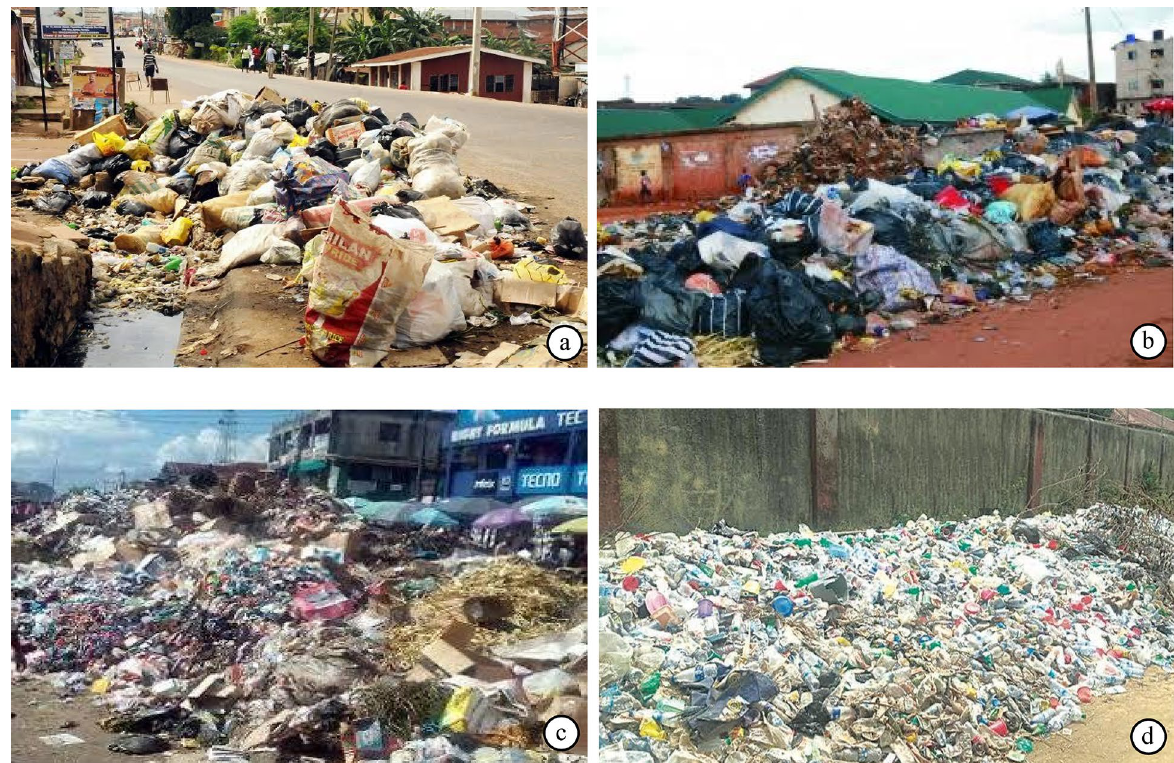
Figure 7. Benin City MSW street-side dumping ( a , b ) and makeshift landfills ( c , d ); photographs taken by F. O. Iyalomhe on 10 May 2020.